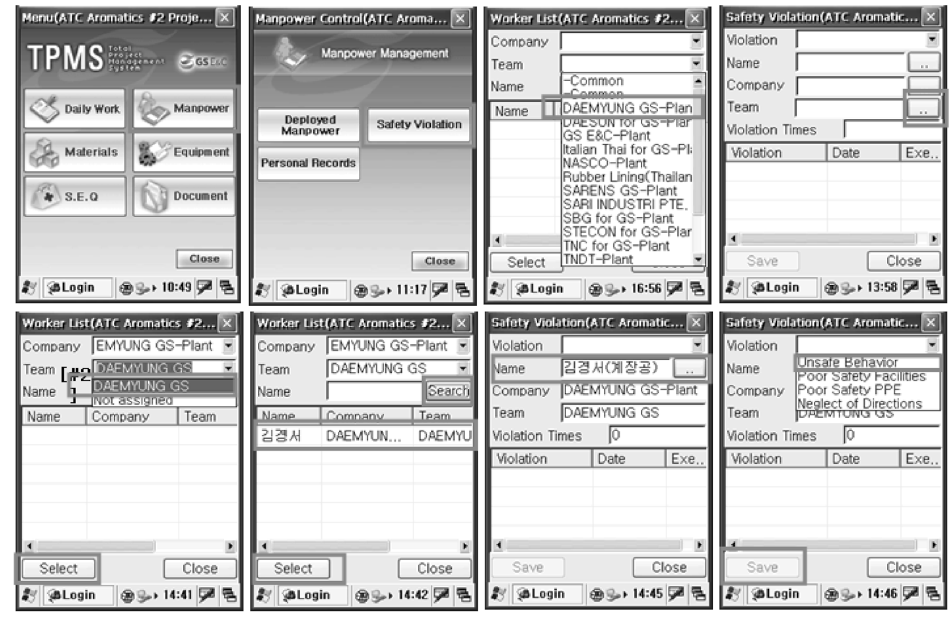
Fig. 9. Safety violation on PDA